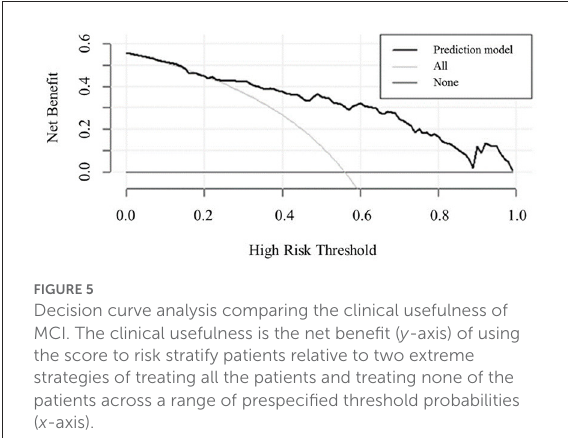
FIGURE5 Decision curve analysis comparing the clinical usefulness of MCI. The clinical usefulness is the net benefit ( y -axis) of using the score to risk stratify patients relative to two extreme strategies of treating all the patients and treating none of the patients across a range of prespecified threshold probabilities ( x -axis).